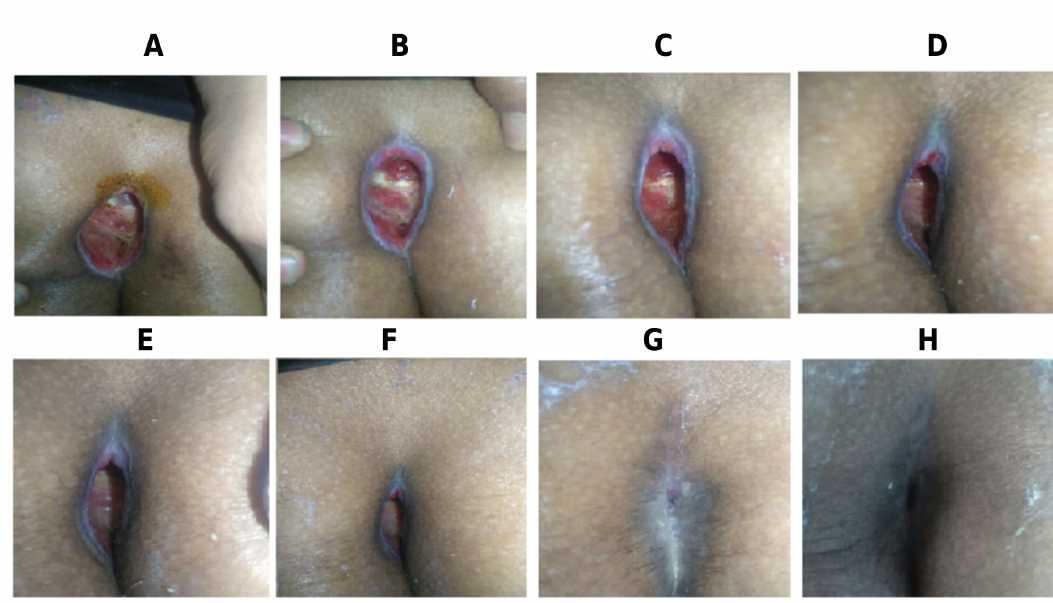
Figure 2. E ff ect of honey on steps of healing of open method of pilonidal sinus.